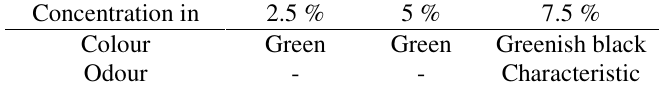
Table 2 . Evaluation of general characteristics.